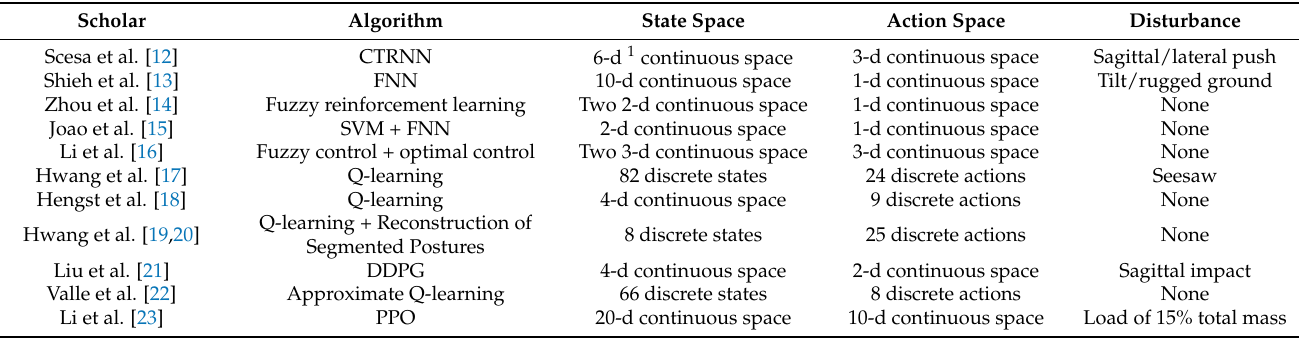
Table 1. Summary of learning-based balance control